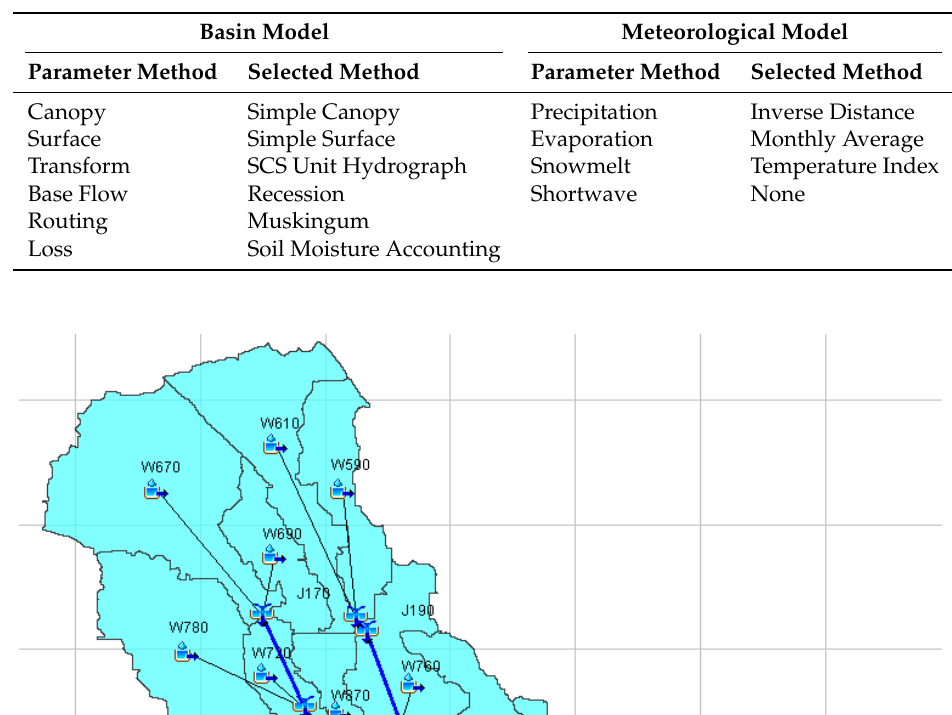
Table 1. Selected methods of HEC-HMS model.